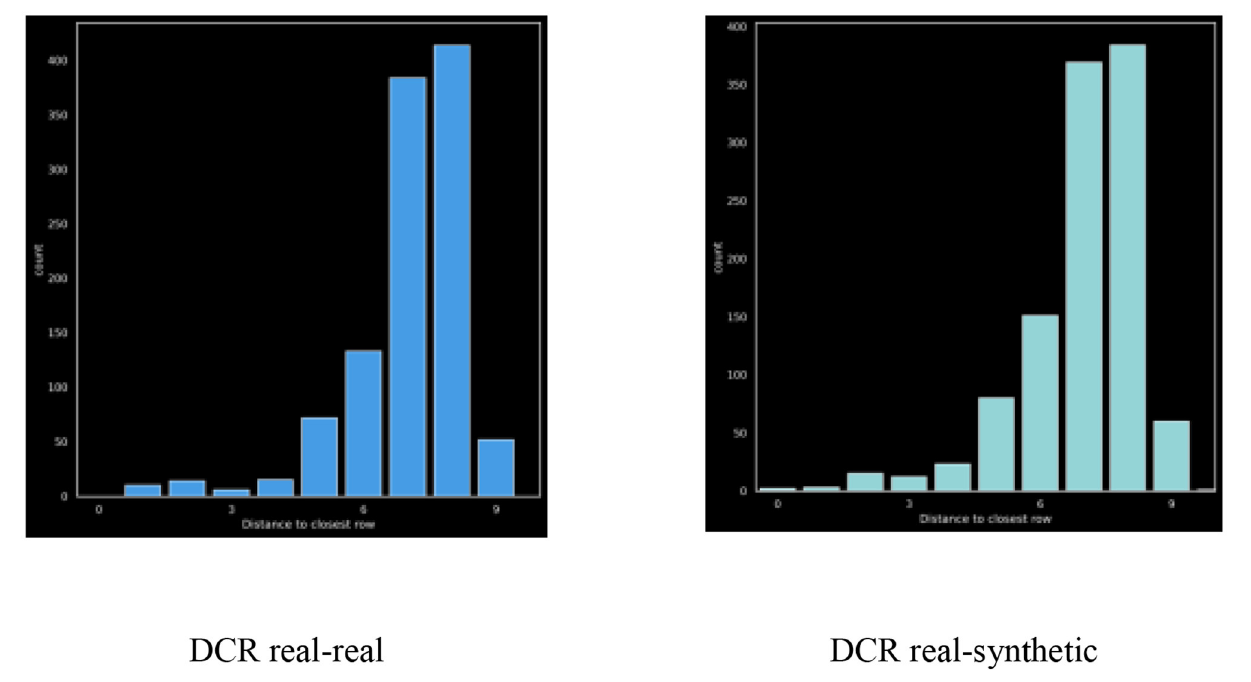
FIGURE 6 | DCR – real on the left (blue), synthetic on the right